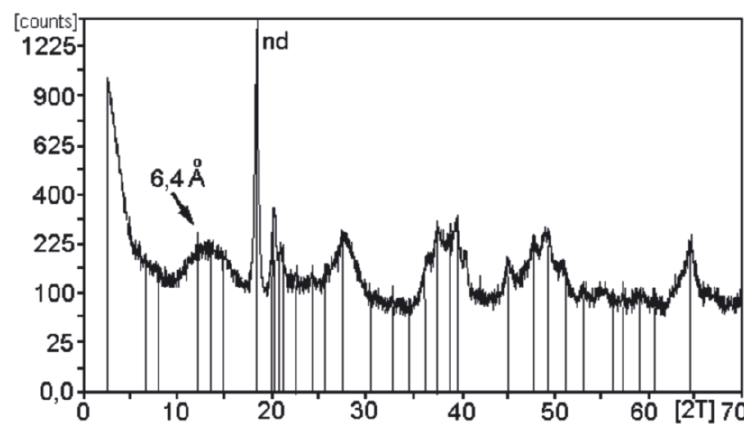
Figure 5. The X-ray diffraction (XRD) curve shows nordstrandite reflections as well as the pseudoboehmite reflections.